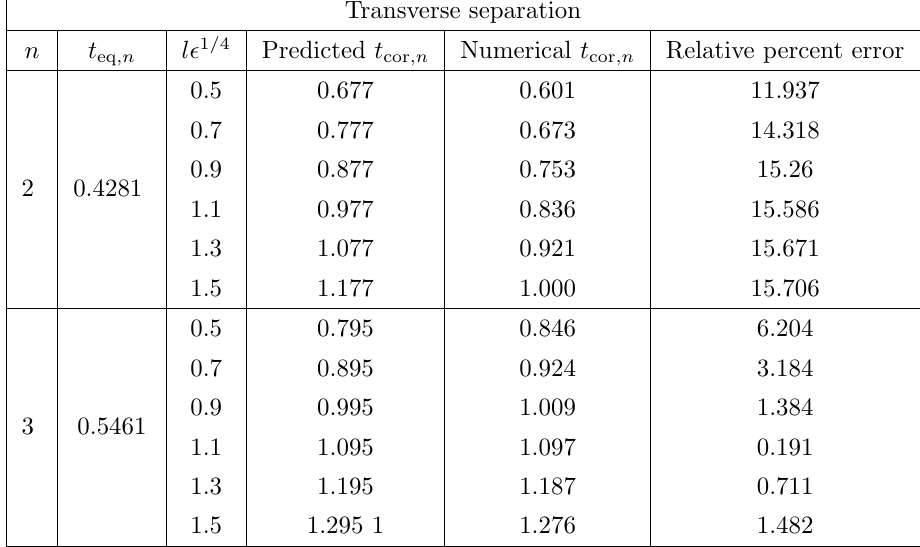
Table 5 . Example equilibrium times of the 1-point functions, t eq ;n , and 2-point functions, t cor ;n , in a thermalizing (cid:13)uid (dual to the evolution towards a RN black brane geometry). Longitudinal separation